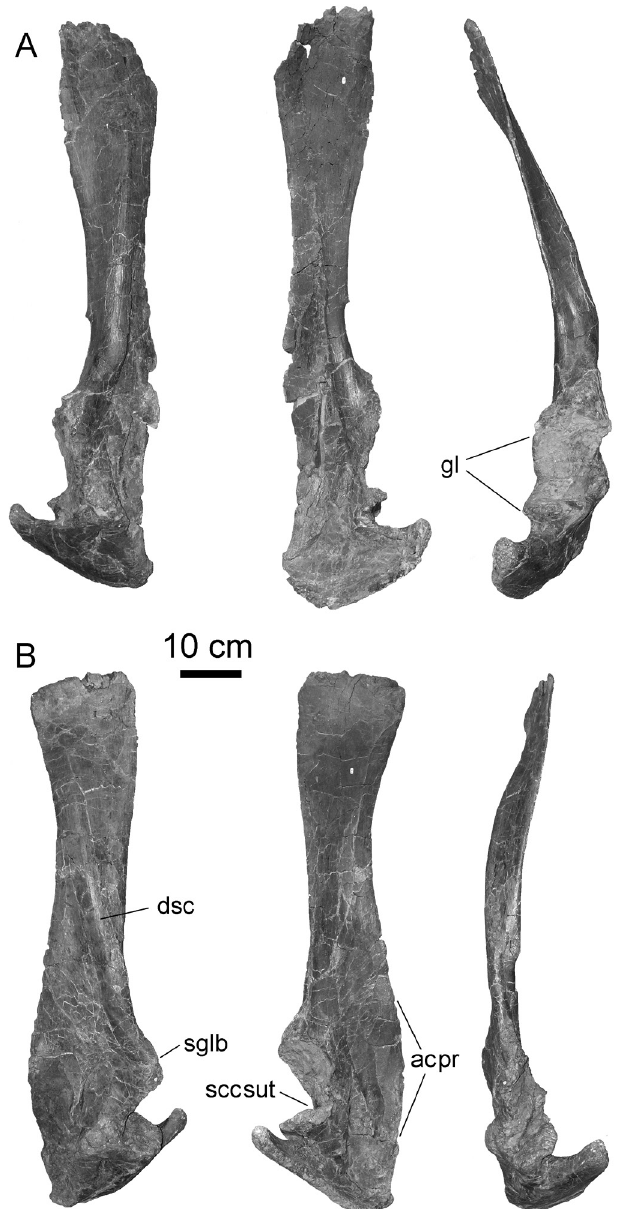
Figure 14. Scapulocoracoids. A, right scapulocoracoid in lateral, medial, and posterior views; B, left scapulocoracoid in lateral, medial, and posterior views. Vagaceratops irvinensis , CMN